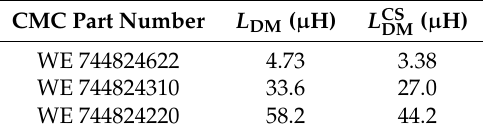
Table 5. L DM for different CMCs with and without the effect of a nearby conducting